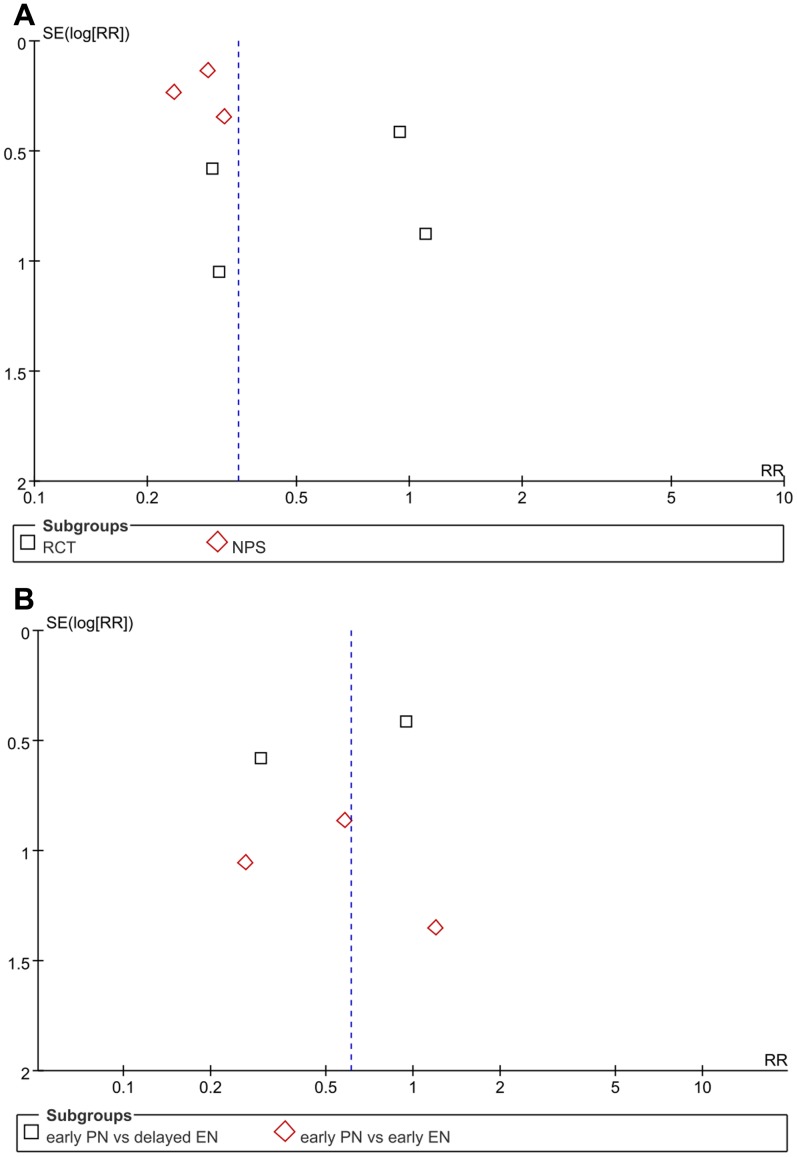
Funnel plots for the detection of publication bias.(A) Funnel plot of studies evaluating the effects of feeding timings on mortality, which is approximately symmetric. (B) Funnel plot of studies evaluating the effects of feeding routes on mortality, which appears to be symmetric.